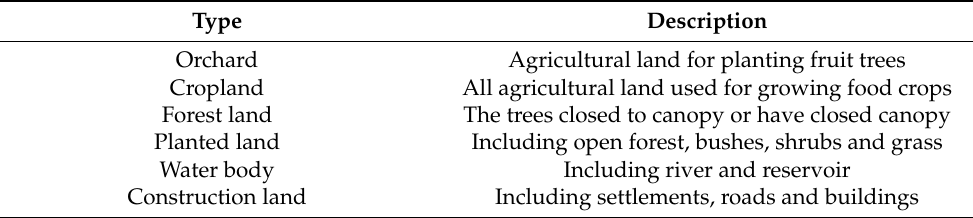
Table 1. Description of land use/cover types identified in the study area. Type